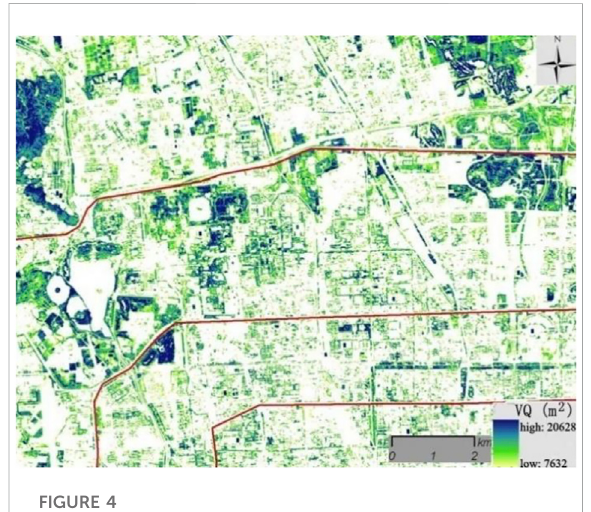
FIGURE 5 Relationships between mean T s , mean ET and mean LAI.